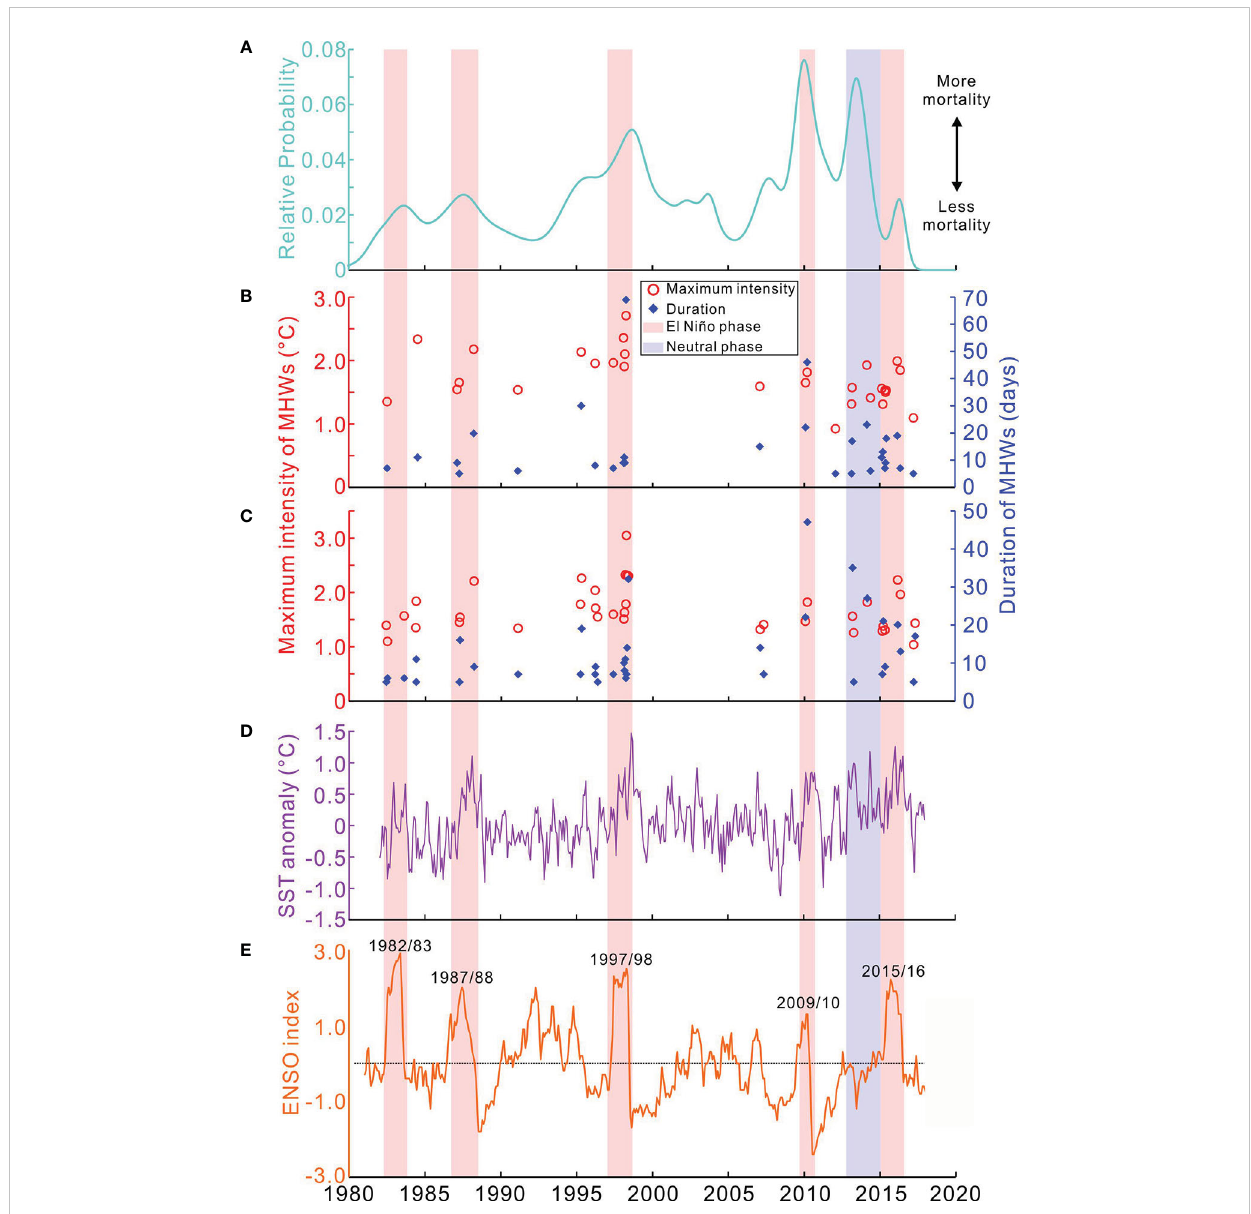
FIGURE 9 Past coral mortality and thermal disturbances: (A) The relative probability of U-Th dates of dead assemblages; MHWs (represented as maximum intensity) occurred in Meiji (B) and Dongmen (C) extracted from the summertime (May − September) NOAA OISST dataset (0.25×0.25°) with the R package “ heatwaveR ” (Schlegel and Smit, 2018); (D) monthly SST anomaly extracted from the 2×2° ERSST v5 dataset (centered at 10° N, 114° E); and (E) Multivariate ENSO